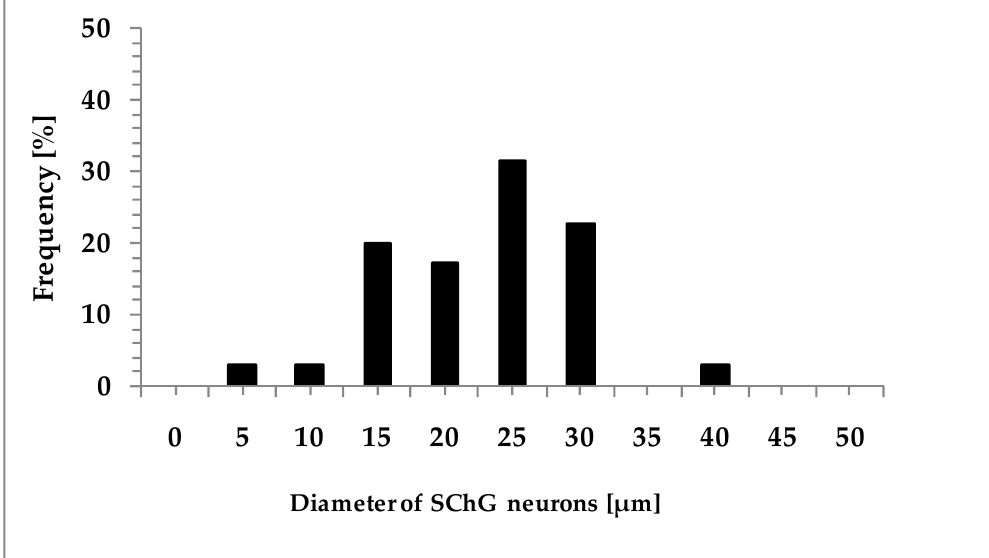
Figure 3. Relative frequency of cell diameter-depending classes of different the skin-projecting SChG neurons (based on n = 400 measured cells ).